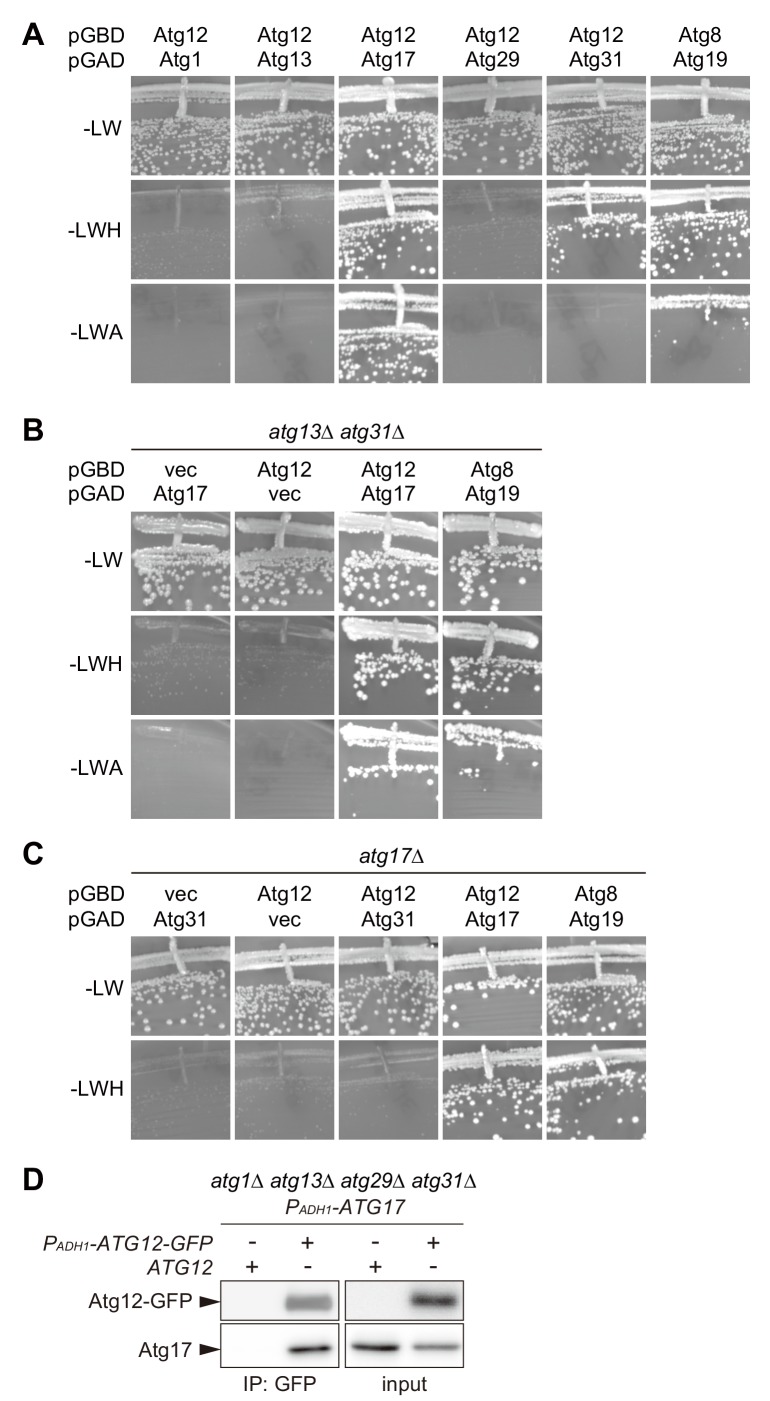
Atg17 interacts with Atg12.(A–C) AH109 cells expressing Atg proteins fused with the Gal4 activation domain (GAD) or Gal4 DNA-binding domain (GBD) as indicated were grown at 30°C for 3 days on SC agar plates lacking leucine and tryptophan for the maintenance of the GAD and GBD plasmids, respectively (-LW), and additionally either histidine (-LWH) or adenine (-LWA) for the assessment of interactions. Cells carrying pGBD-ATG8 and pGAD-ATG19 serve as a positive control. pGAD-C1 and pGBD-C1 were used as vector controls. (D) atg1Δ atg13Δ atg29Δ atg31Δ cells expressing both ATG17 and ATG12-GFP with the ADH1 promoter (PADH1) were treated with rapamycin for 2 hr, subjected to immunoprecipitation using GFP-binding protein-conjugated beads, and the immunoprecipitates were analyzed by immunoblotting using antibodies against Atg12 and Atg17.